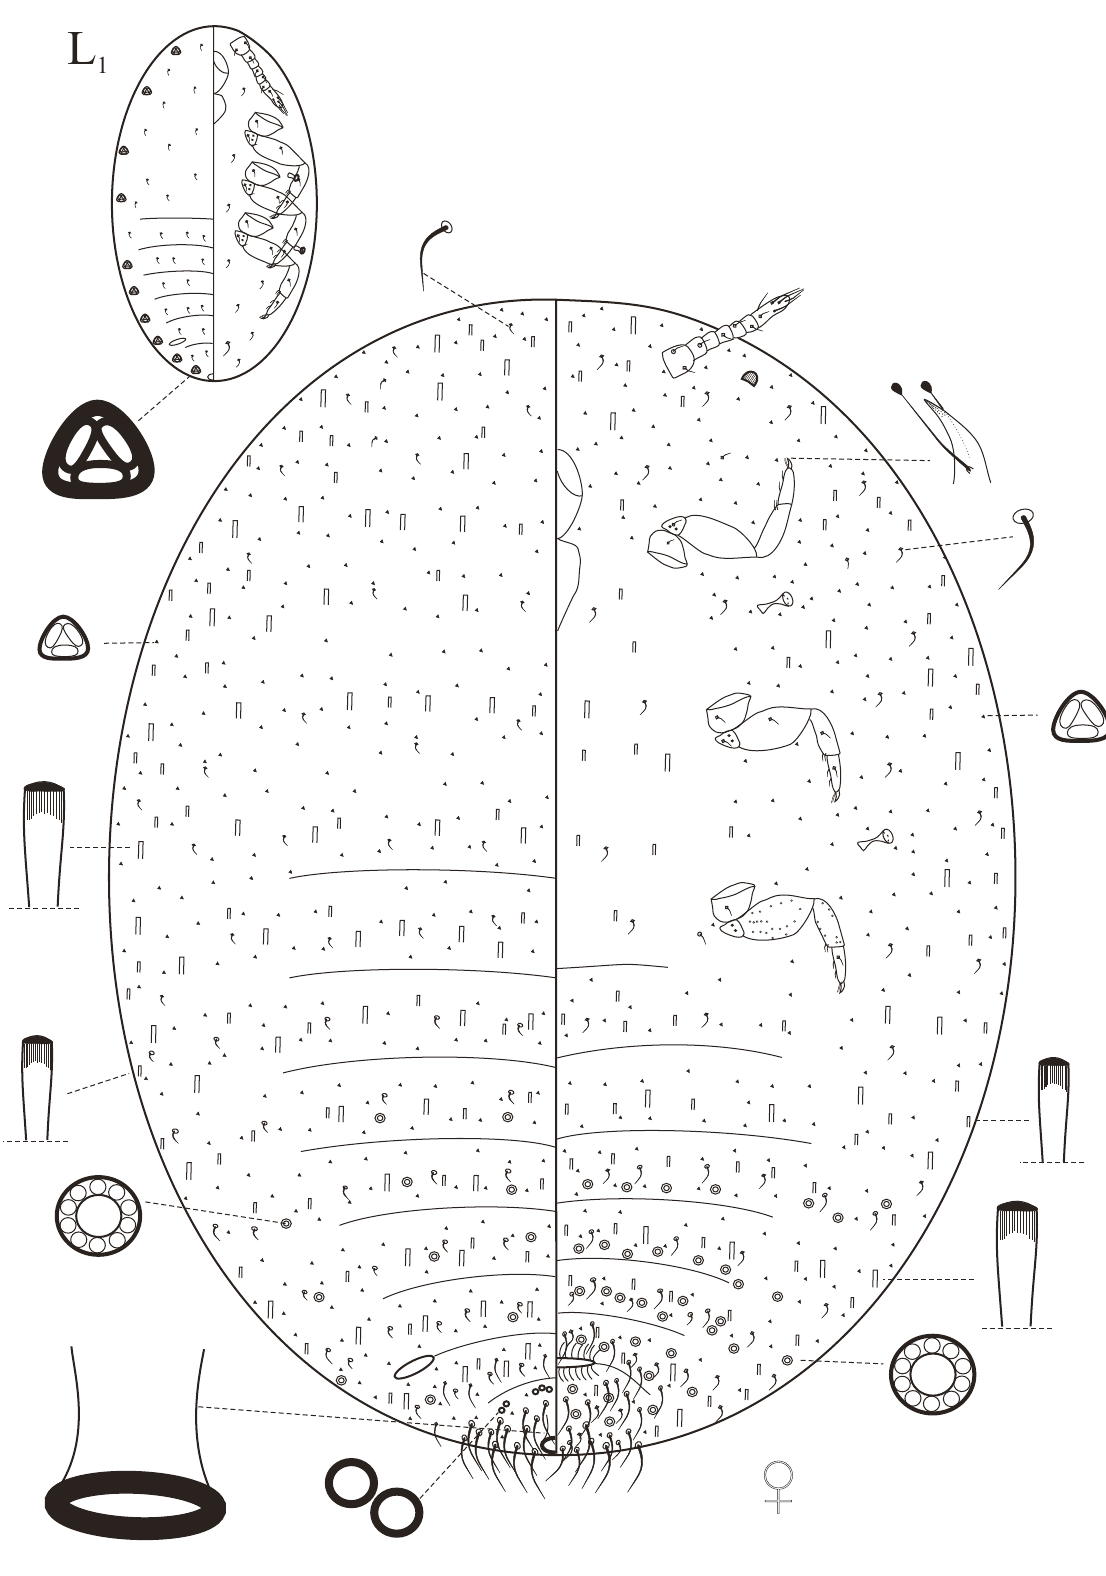
Fig. 3. Mirococcopsis ptilura Gavrilov-Zimin sp. nov., adult female (holotype) and primolarva (L